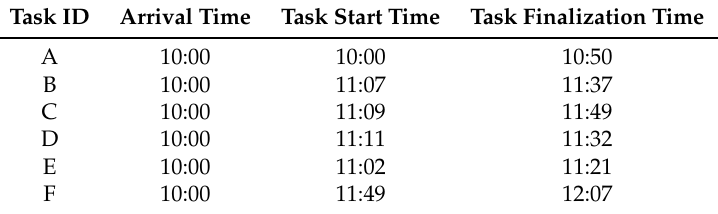
Table 10. Start times of DAG task nodes from Figure